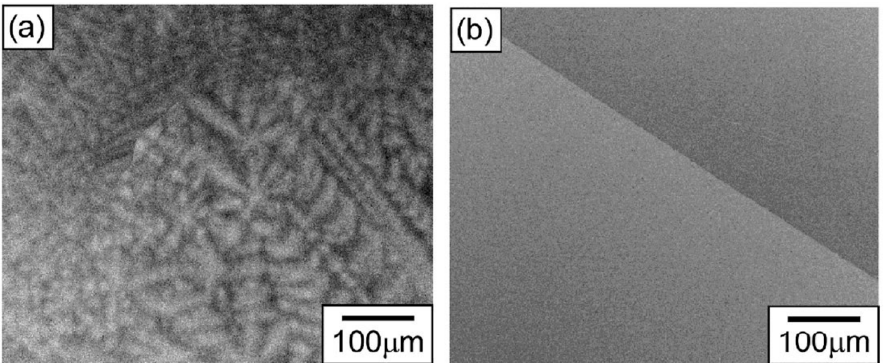
Figure 5. SEM micrographs of equiatomic HfNbTaTiZr polycrystal after arc melting, followed by homogenization treatment at 1773 K for 5 h; ( a ) as cast, ( b ) homogenized. Reprinted with permission from ref. [61]. Copyright 2021 Elsevier.